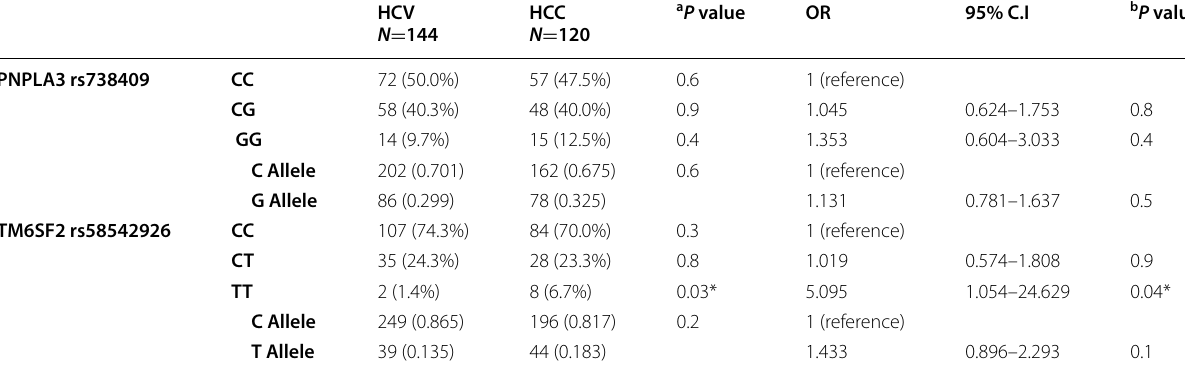
Table 2 Genotype distribution of PNPLA3 rs738409 and TM6SF2 rs58542926 in HCV and HCC